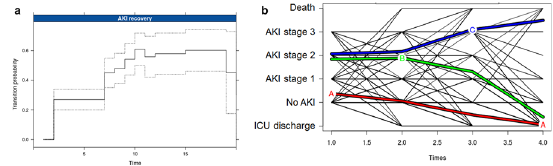
Fig. 1 Evolution of the risk of renal recovery and overall patient trajec‑